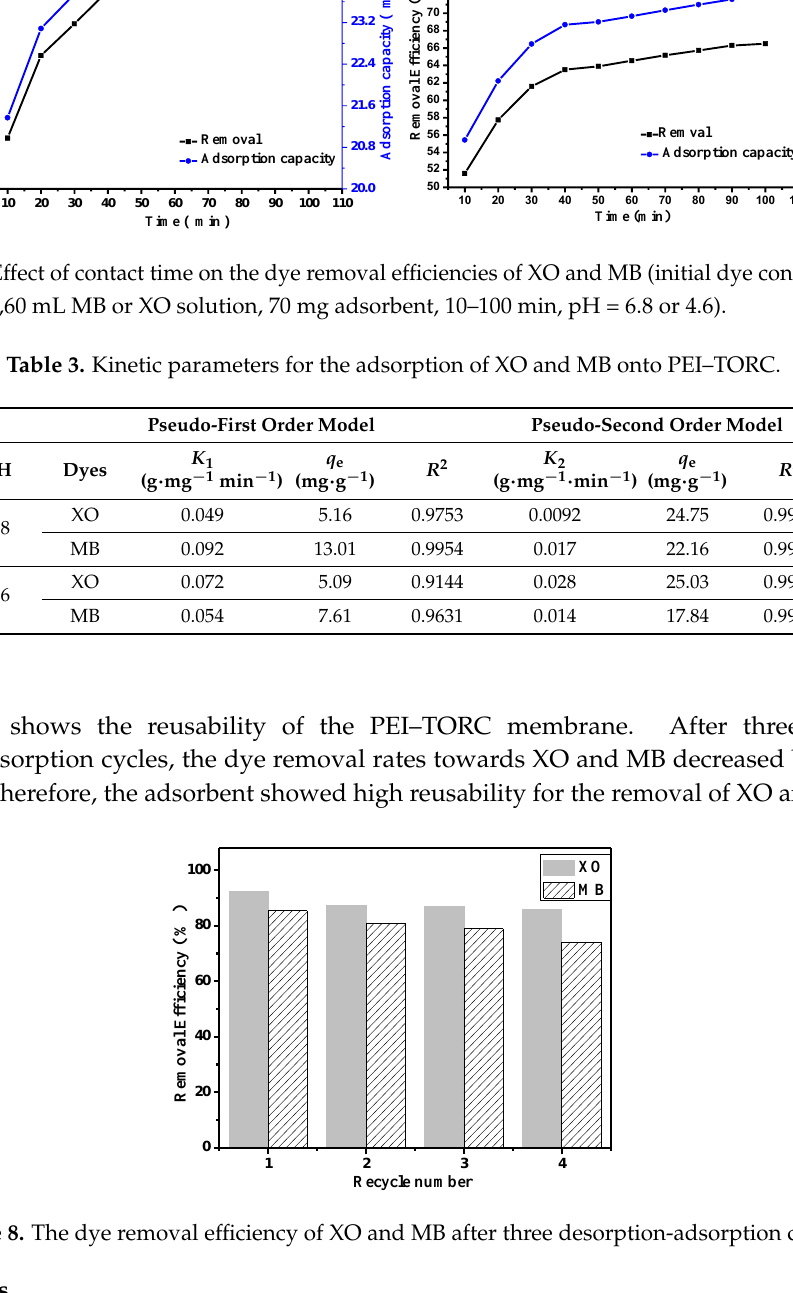
Figure 8. The dye removal efficiency of XO and MB after three desorption-adsorption cycles.